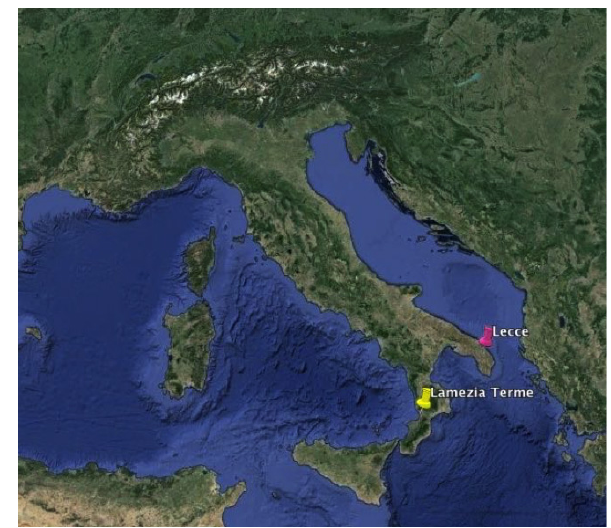
Figure 1. WRF/RAMS domain (same grid at 4km resolution), and location of the experimental sites.